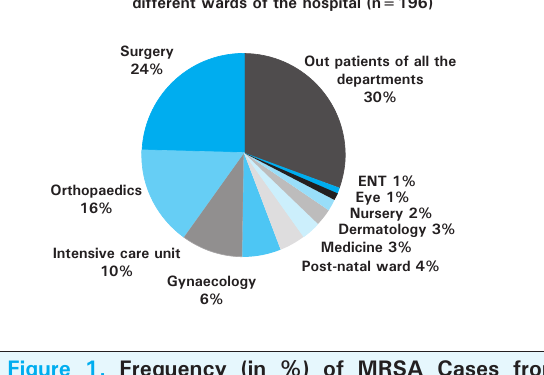
Figure 1. Frequency (in %) of MrsA cases